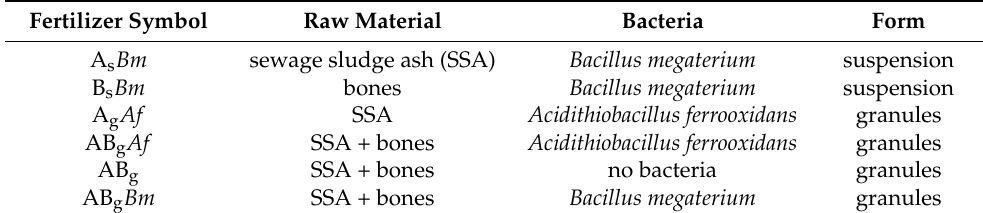
Table 1. Recycled fertilizers tested in the experiments. Fertilizer